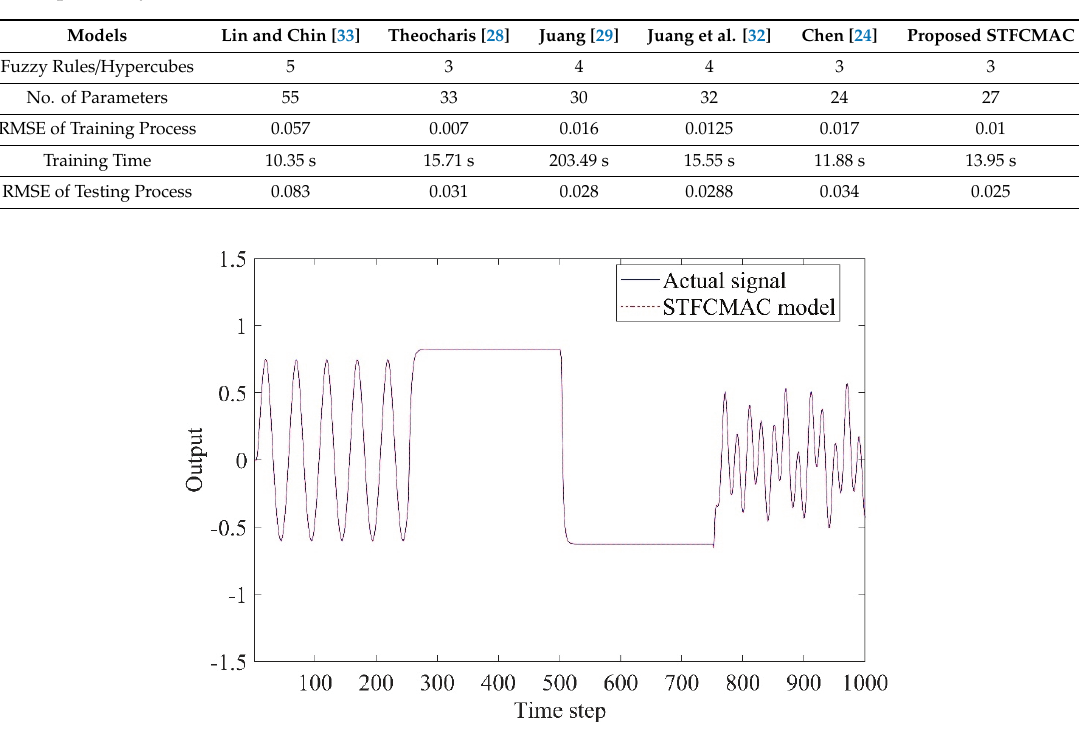
Figure 8. The results of dynamic system identification with a longer input delay obtained using the STFCMAC model.